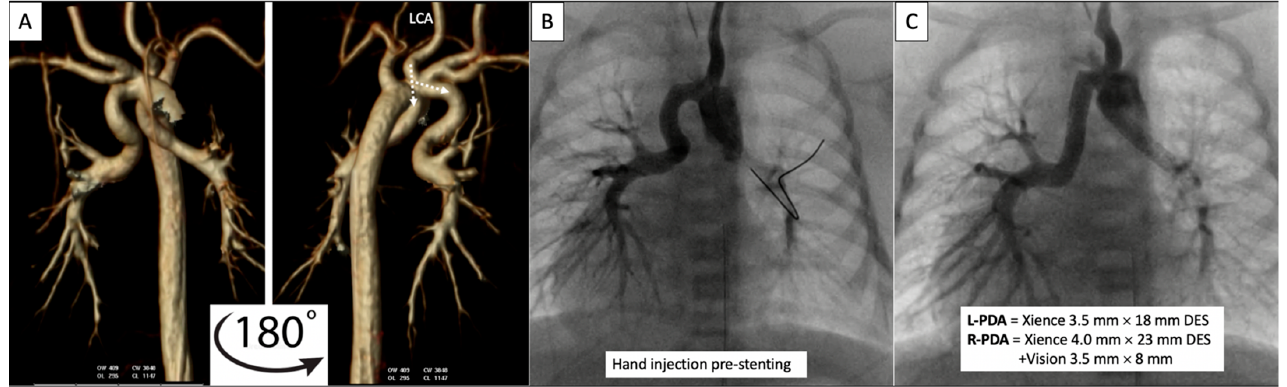
Figure 8. Pre-procedural 3D virtual CT imaging ( A ) predicts the left carotid artery (LCA) as the best access site for bilateral PDA stenting ( B , C ) in a patient with discontinuous PAs. Multi-Link Vision and Xience Alpine TM drug eluting (DES) stents (Abbott Vascular Company, Abbott Park, IL, USA) were used. Revised from ref [9].